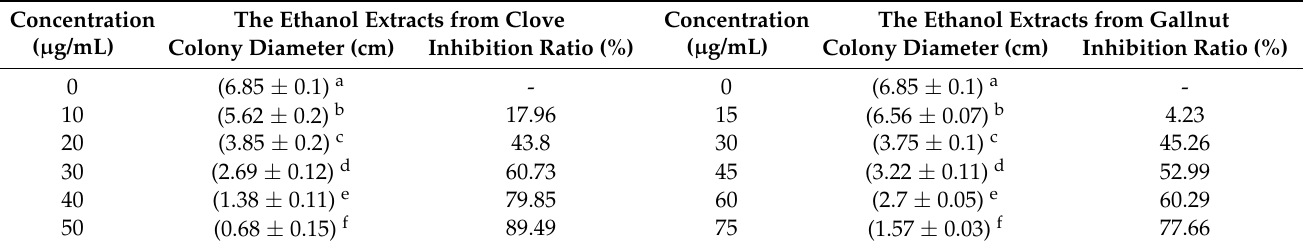
Table 2. Indoor toxicity of ethanol extracts from two plants to R. solani